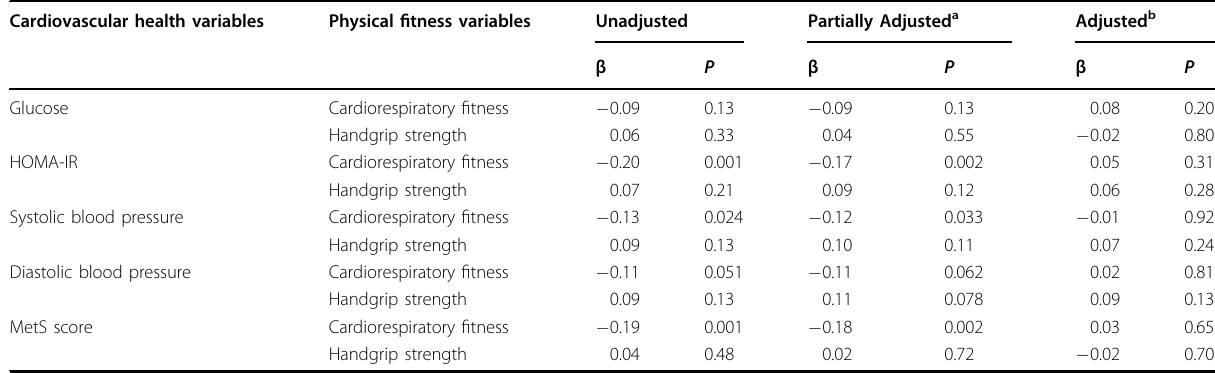
Table 3 Associations of physical fi tness with cardiovascular health in early pregnancy examined by linear regression. Cardiovascular health